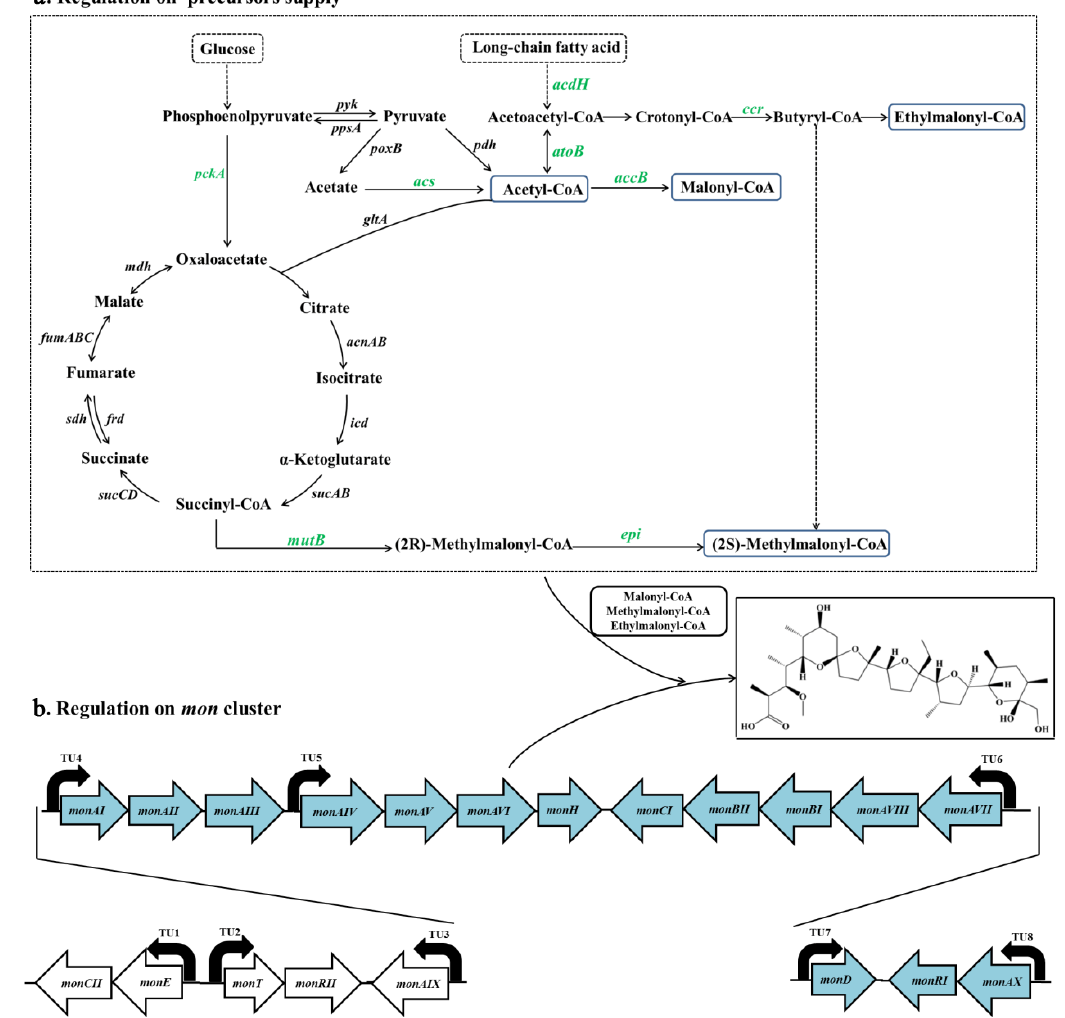
Figure 6. Proposed regulatory mechanism of Crp for monensin biosynthesis. ( a ) The primary metabolism of precursor supply for monensin biosynthesis. The metabolic genes under Crp regulation are shown in green. ( b ) The monensin biosynthetic gene cluster. The mon genes of the transcription units (TUs) under Crp regulation are shown in blue. Curved black arrows represent transcription directions. pyk , pyruvate kinase gene; ppsA , phosphoenolpyruvate synthase gene; poxB , pyruvate oxidase gene; pdh , pyruvate dehydrogenase gene; acnAB , aconitate hydratase gene; icd , isocitrate dehydrogenase gene; sucABCD , succinyl CoA synthase gene; frd , fumarate reductase gene; sdh , succinate dehydrogenase gene; fumABC , fumarase ABC gene; mdh , malate dehydrogenase gene; gltA , citrate synthase gene.